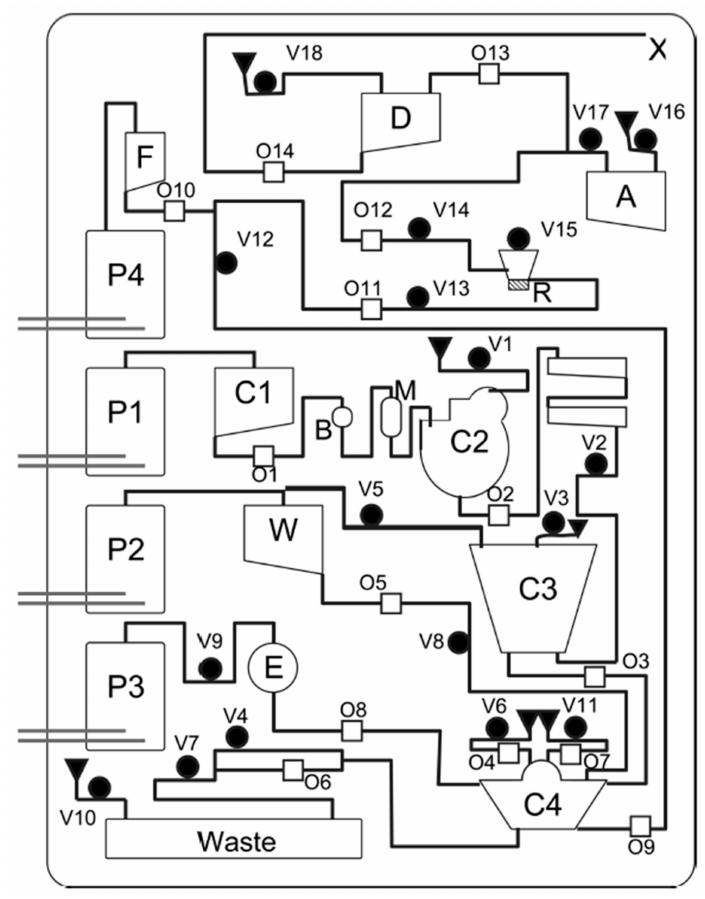
Figure 6. Overview of the MiDAS cartridge for DNA extraction, amplification, and post PCR denaturation, with (P1–P4) electrochemical pumps; (C1) lysate input chamber; (C2) bead chamber; (C3) mixing/incubation chamber; (C4) washing and elution chamber; (R) PCR chamber; (A) DNA extract archive chamber; (D) denaturation chamber; (M) bead storage chamber; (B) binding buffer chamber; (W) wash solution storage chamber; (E) elution buffer storage chamber; (F) Formamide/ILS storage chamber; (X) output to CE. A closing valve is represented by b; an opening valve by 0; and a vent by 1. Reprinted (adapted) with permission from [14]. Copyright 2010 American Chemical